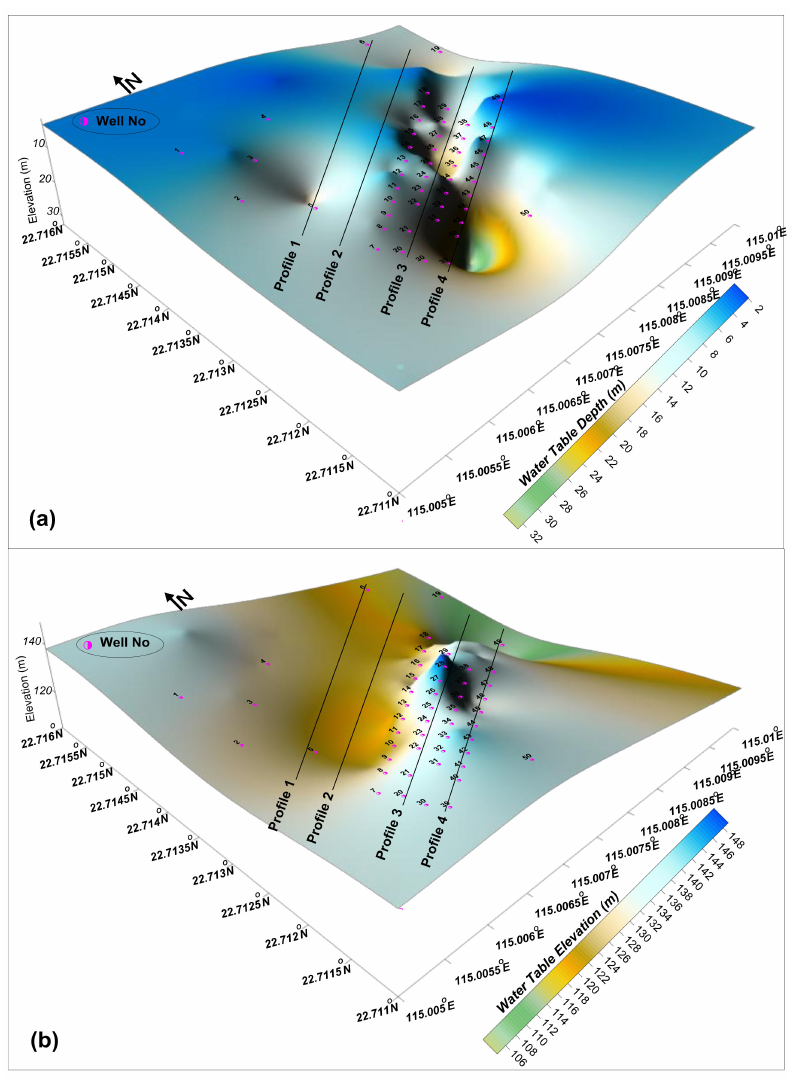
Figure 7. Water table in the study areawith respect to ( a ) depth and ( b )